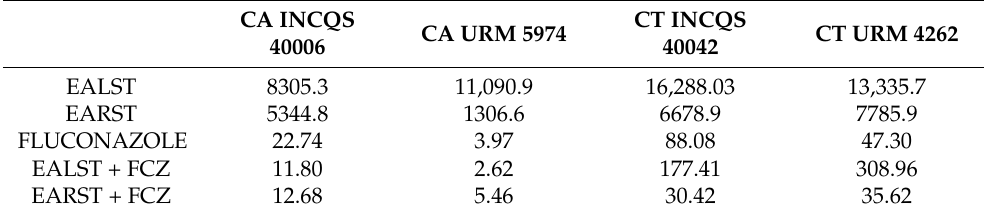
Table 4. 50% Inhibitory Concentrations (IC 50 ) of microorganisms ( µ g/mL) by aqueous extracts of Spondias tuberosa .